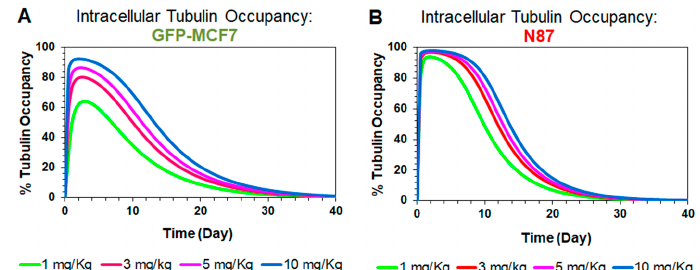
Figure 5. Simulations for intracellular occupancy of tubulin with MMAE ( Occ (cid:2904)(cid:2931)(cid:2912) ) in GFP-MCF7 ( A ) and N87 ( B ) tumor bearing mice after administration of single intravenous dose of 1 mg/kg (green), 3 mg/kg (red), 5 mg/kg (pink), and 10 mg/kg (blue)